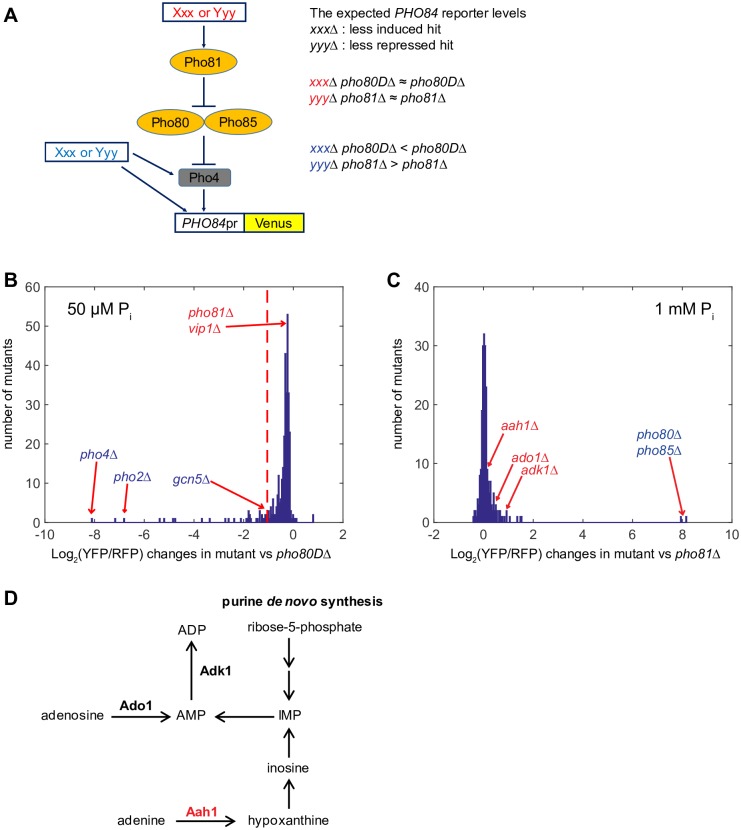
Identification of genes acting upstream of the Pho80/Pho85/Pho81 kinase complex.(A) A schematic diagram depicting the expected outcome of epistasis analysis depending on whether or not a mutant is defective in the signaling process upstream of Pho80/Pho85. Genes in red act upstream of Pho80/Pho85 and those in blue do not act upstream of Pho80/Pho85. (B) The PHO84 reporter levels of double mutants carrying the less induced hits and pho80DΔ in 50 μM Pi conditions. All 380 less induced hits were used to generate the double mutants. The PHO84 reporter levels of double mutants in (B) were normalized to that of pho80DΔ. A red dashed line in (B) indicates the maximum PHO84 reporter level of double mutants generated by one of the known downstream genes (pho80DΔ gcn5Δ). (C) The PHO84 reporter levels of double mutants carrying the less repressed hits and pho81Δ in 1 mM Pi conditions. All 243 less repressed hits were used to generate the double mutants. The PHO84 reporter levels of double mutants in (C) were normalized to that of pho81Δ. In (B) and (C), mutants in blue and red are defective in signaling process downstream and upstream of Pho80/Pho85, respectively. (D) A schematic diagram depicting adenine nucleotide metabolism. A gene in red is identified in this study and those in bold black are previously identified.